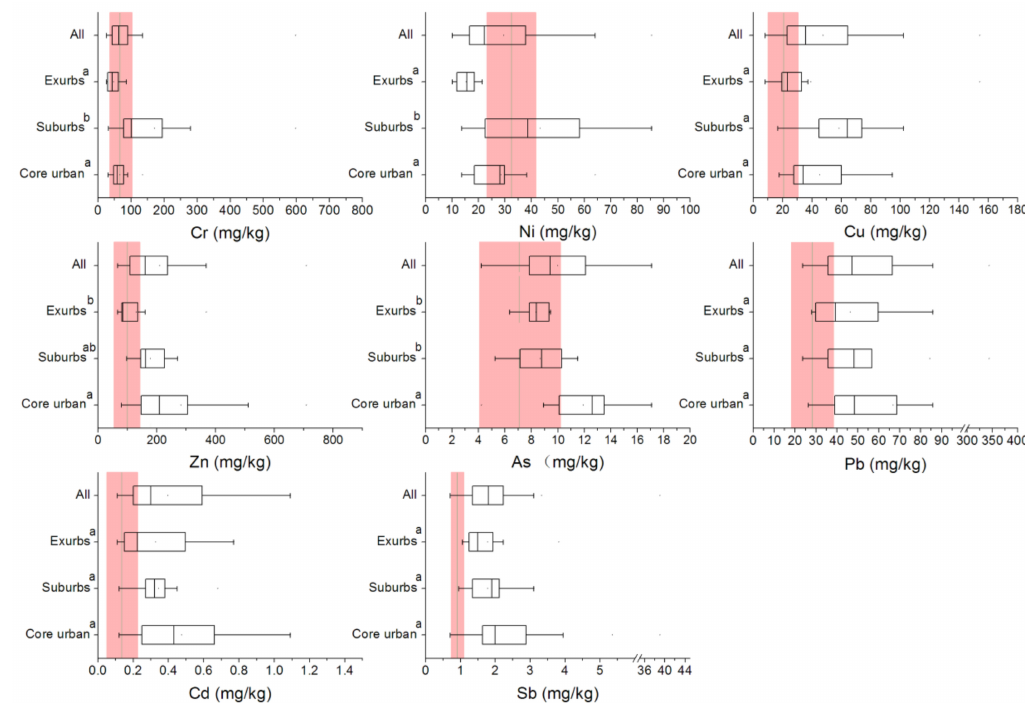
Figure 3. The background values (arithmetic mean ± stand deviation, red region) and trends in terms of changes in the concentrations of eight heavy metals across urbanization gradients. The same letter “a and b” indicates no significant differences across the urban gradients at p < 0.05. 3.2. The Spatial Distribution of the Heavy Metals during the Urbanization Gradients The inverse distance weighted (IDW) interpolated spatial patterns of Cd, Ni, Cu, Zn, As, Cd, Sb and Pb concentrations in the topsoil of the study area are presented in Figure 4.